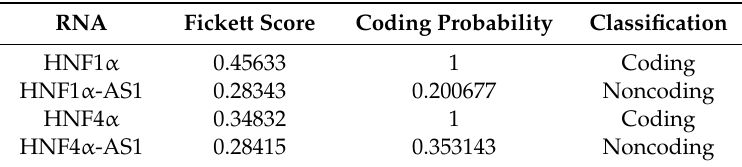
Table 2. The coding potentials of HNF1 α -AS1 and HNF4 α -AS1. RNA Fickett Score Coding Probability